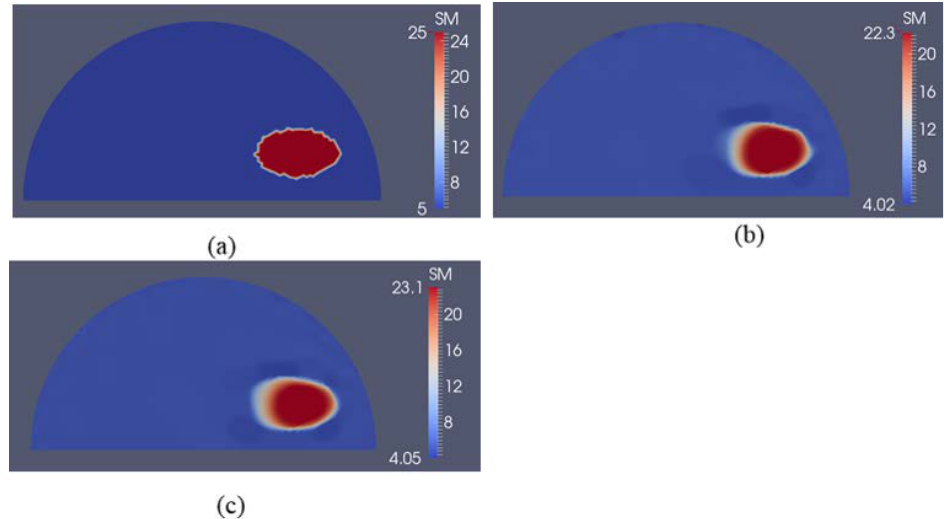
Figure 12. Shear modulus reconstructions with 0.1% noise. ( a ) Target shear modulus distribution with an elliptically shaped inclusion is defined to study detectability of the inclusion shape; ( b , c ) Reconstructed shear modulus distribution using 5 and 10 boundary displacement data sets, respectively (unit in the scale bar: kPa). Note: “SM” stands for shear